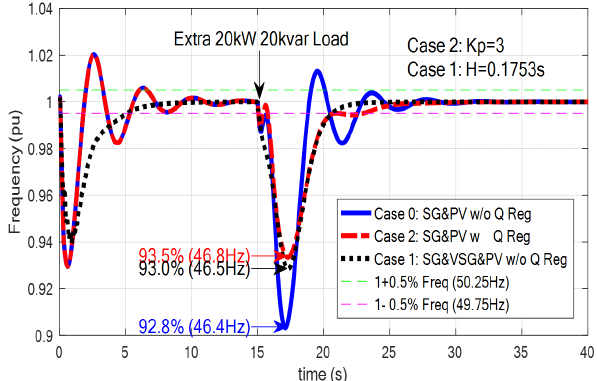
Figure 8. Frequency transients under load connection at the 15th s without ancillary service (blue), with the proposed method (red). In (black) the same simulation done using virtual synchronous generator (VSG)